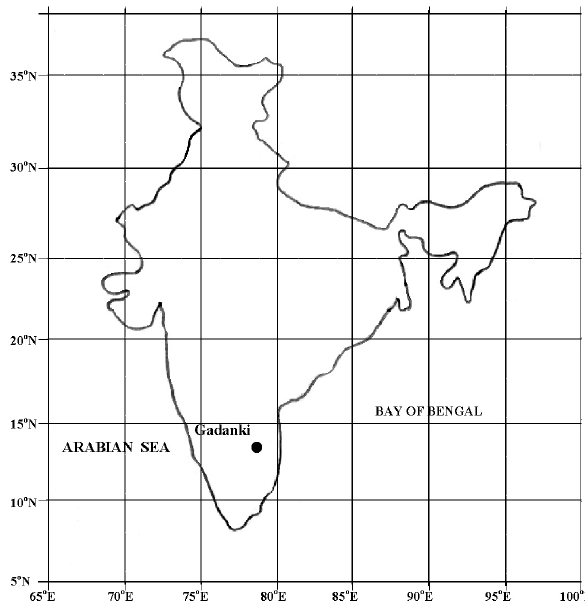
Fig. 1. A map showing the location of observational